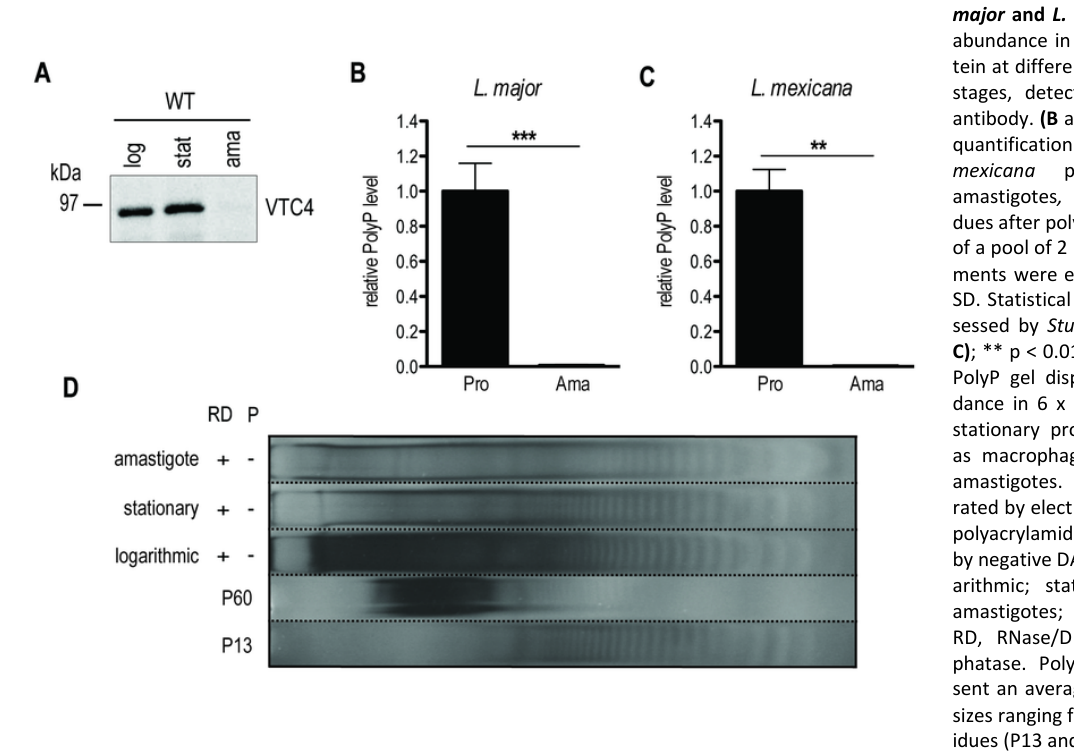
FIGURE 6: VTC4 and polyP levels at different life cycle stages of